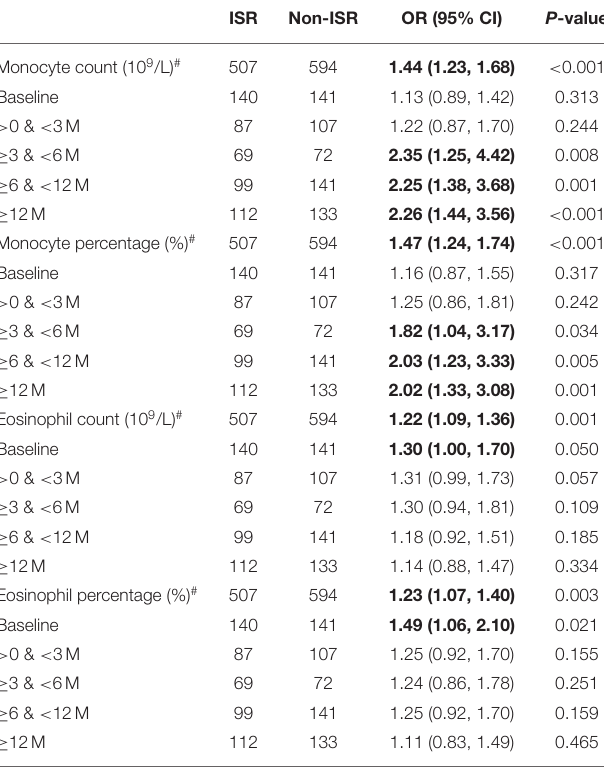
TABLE 3 | OR (95%CI) of ISR associated with per interquartile range (IQR) increment of each hematological index during the follow-up period * . P -value ISR Non-ISR OR (95%